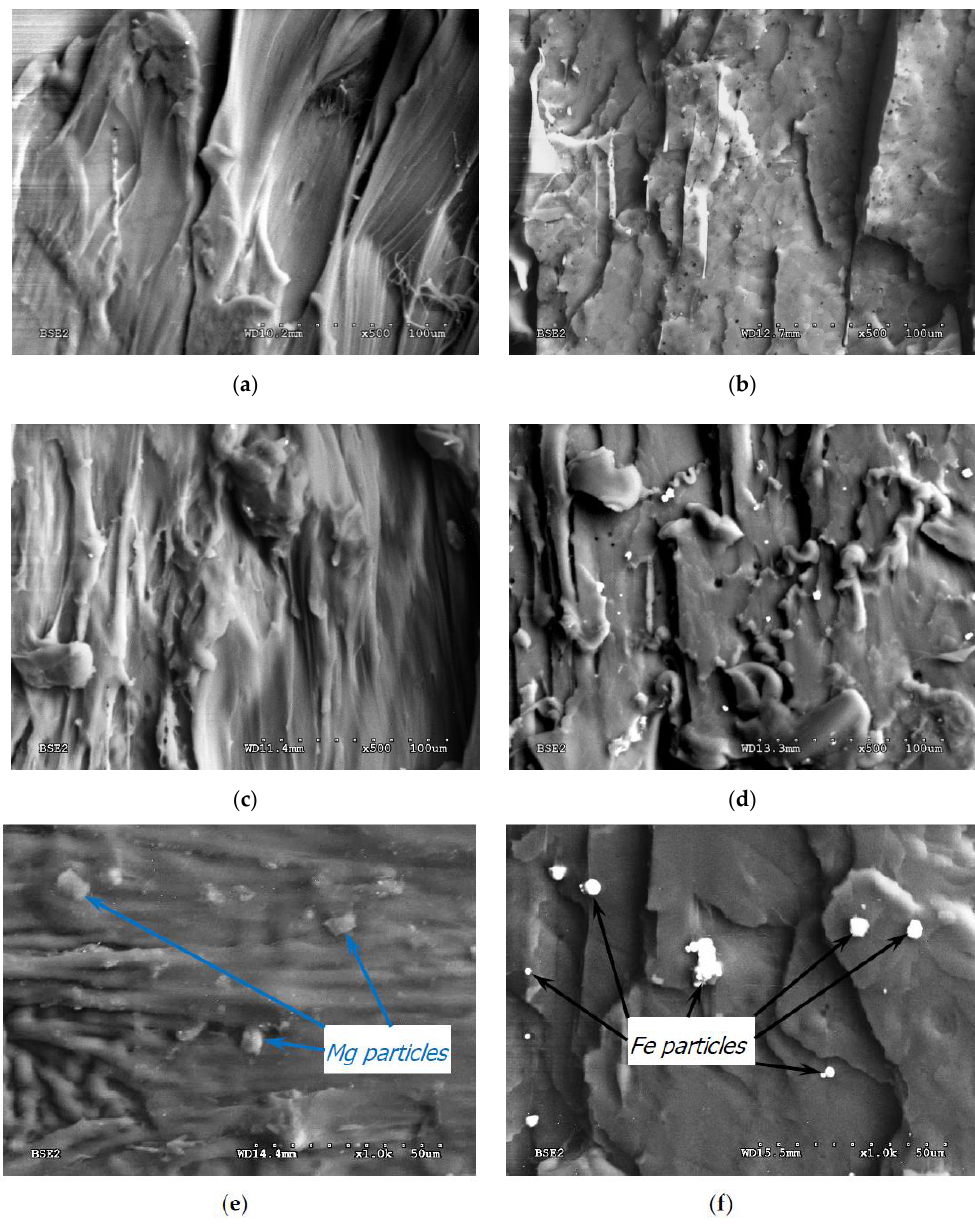
Figure 4. SEM images of the fracture surface of the broken composite samples obtained after tensile tests: ( a ) PLA, ( b ) PLA-5%PE, ( c ) PLA-5%Mg, ( d ) PLA-5%Fe (mag. × 500), ( e ) and ( f ) PLA-5%Mg and PLA-5%Fe powder particles, respectively (mag. ×1000).